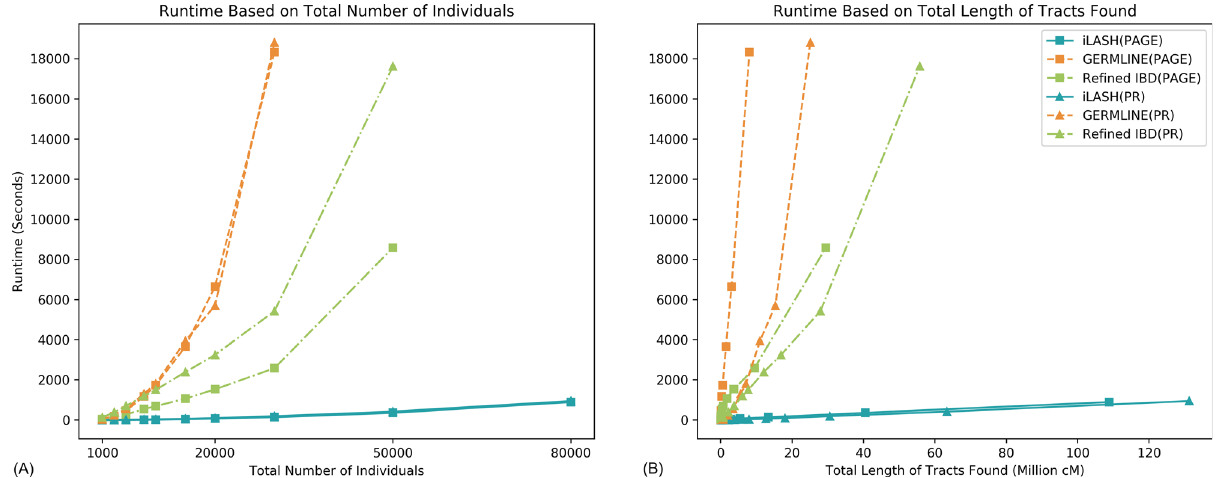
Fig. 3 Comparison of runtimes among algorithms. IBD computation runtime in seconds for iLASH, Re fi ned IBD, and GERMLINE on synthesized haplotypic data simulating all of PAGE and Puerto Rican (PR) populations IBD patterns: ( A ) as the number of individuals grows, ( B ) as the total output (total length of tracts found) grows. Source data are provided as a Source Data fi